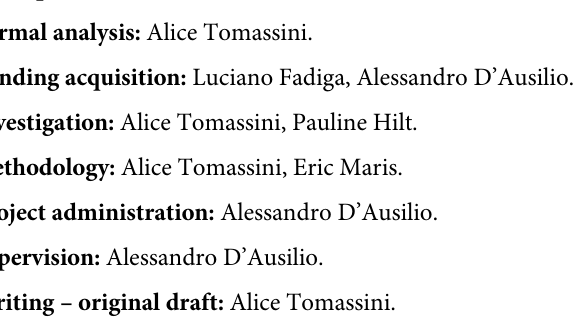
percentage change in coherence averaged over frequencies between 20 and 30 Hz and lags between − 0.08 and +0.08 seconds (i.e., lag of max. beta coherence on all trials [0 seconds] ± 1 SD across subjects), respectively. (C) Topographies show coherence at frequency 25 Hz and lag zero for all trials (top), hits (middle), and misses (bottom). S3 Fig. Prestimulus modulations in EEG alpha power do not account for cortico-force coherence modulations. (A) Time-frequency plot of power modulations (hits/misses) aver- aged over selected occipital EEG electrodes (marked in gray in the topographic map). The topography shows the hits-misses difference in power calculated at stimulus onset (0 s) and at frequency 10.5 Hz. (B) Nonlagged (left; same as in Fig 3) as well as lagged and time-resolved (right, same as in Fig 6) coherence analysis performed on data stratified on occipital alpha power. Specifically, for the stratification we used the power at frequency 10.5 Hz in the relevant time window (left: 1.6-second prestimulus; right: 0.3-second windows from − 1 to 0 seconds), averaged over selected occipital channels where the hits-misses difference is maximal (Oz, O1, O2, POz, PO3, PO4; highlighted in gray in A). The power distributions were compiled for hits and misses and then binned in 10 equally spaced bins. The number of trials in each bin for hits and misses was then equated by a random subsampling procedure which aims at matching as much as possible the parameter averages (as implemented in Fieldtrip, function: ft_stratify, method: ‘histogram’, ‘equalbinavg’). This procedure led on average to the removal of 73.05 ± 5 and 76.55 ± 4.4 trials per subject (mean ± SEM) for the first and second analysis, respectively. The difference in coherence between hits and misses after data stratification has then been evaluated by means of a one-tailed cluster-based permutation test at frequency 10.5 Hz and, for the second analysis, at time point − 0.16 seconds and lag − 0.2 seconds. For both analyses, we obtain significant results: black asterisks mark the electrodes that survived cluster-based permutation test for the hits-misses contrast. EEG, electroencephalography. S4 Fig. Poststimulus alpha cortico-force coherence. Lag-frequency coherence representation as in Fig 4C but averaged over the poststimulus period (0–0.5 seconds) for all trials as well as separately for hits- and misses-trials. Topographies show corresponding poststimulus coherence (spatially z- scored before averaging across subjects) at 10.5 Hz and lag − 0.2 seconds for all trial